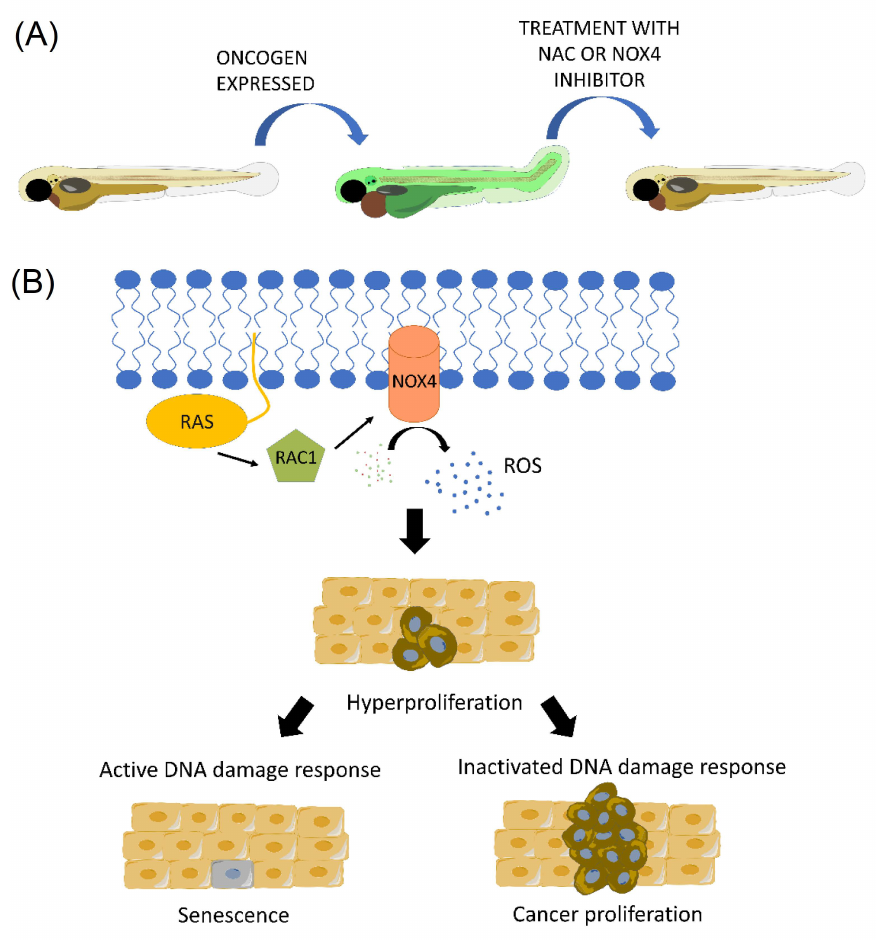
Figure 4. ( A ) ROS scavengers and NOX4 inhibition rescue cell from death and larval malformations originated by the overexpression of oncogenic RAS; ( B ) RAS-induced ROS are produced by NOX4 and induce tumor hyperproliferation by dependent and independent DNA damage response